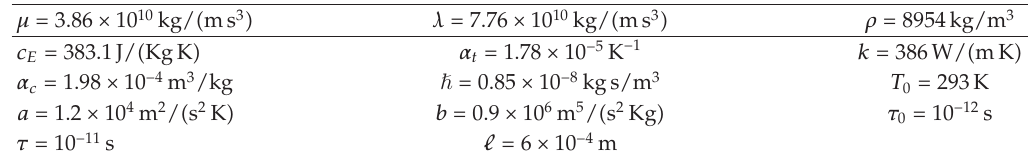
Table 1: Values of the